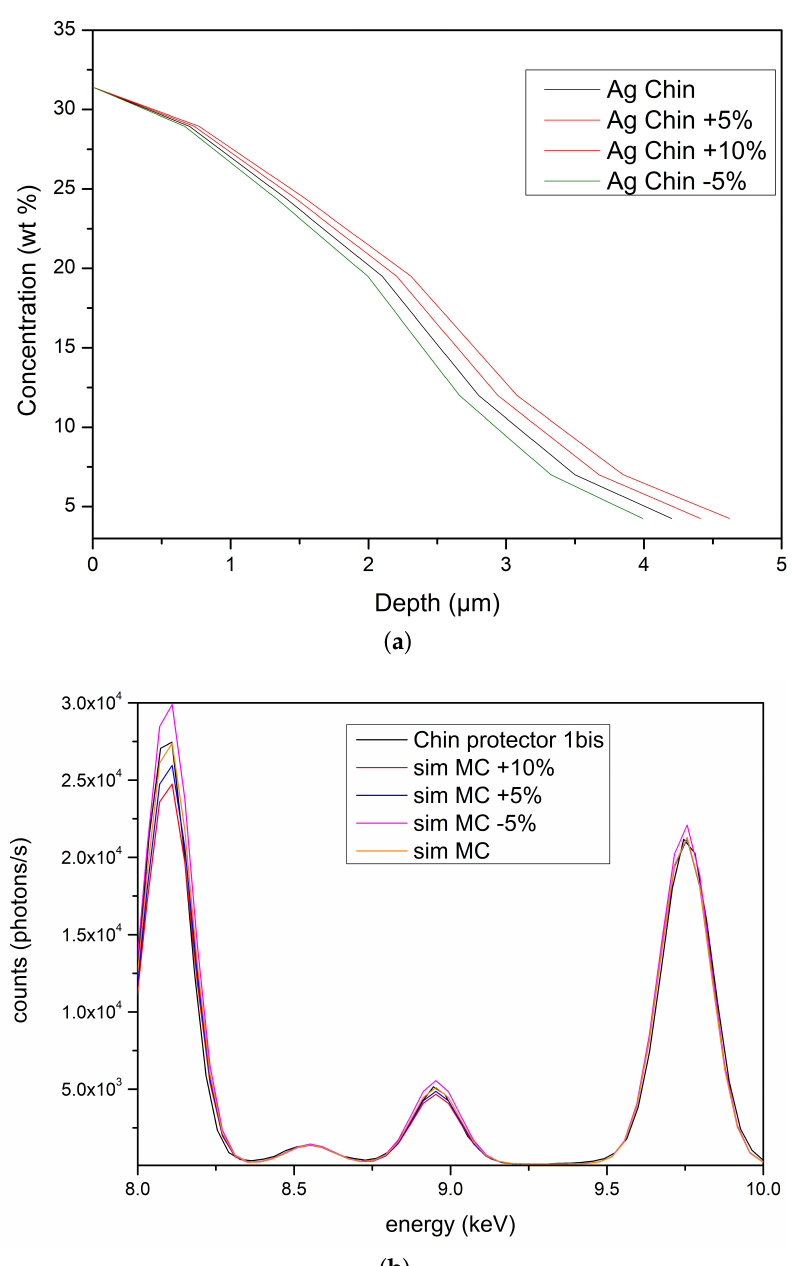
Figure 10. Influence of changes in the silver gradient slope on MCS simulations. ( a ) different slopes and ( b ) corresponding spectra (copper peaks